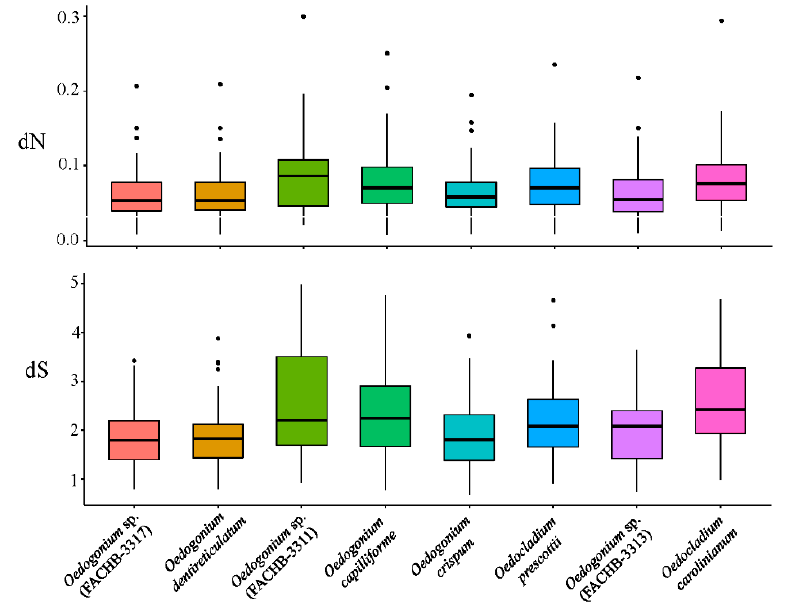
Figure 2. Boxplots of the non-synonymous (dN) and synonymous (dS) substitutions for each species of the eight Oedogoniales species. For each species, the box represents values between quartiles, outliers are shown as black points, and black lines inside the box show median values.